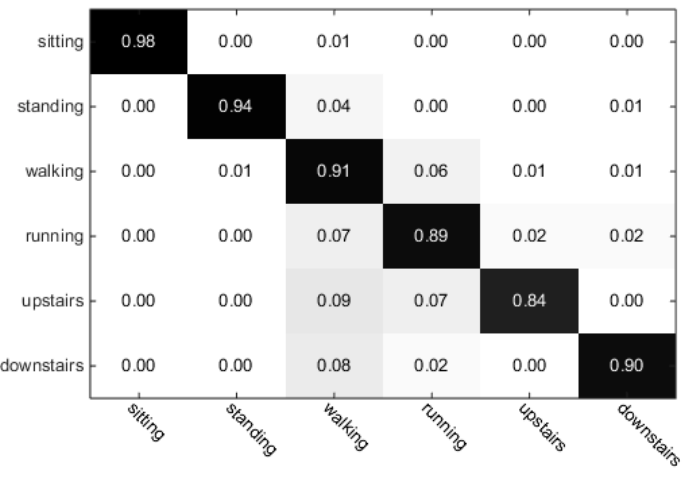
Figure 7. The classification results of climbing upstairs activity after H-SVM.